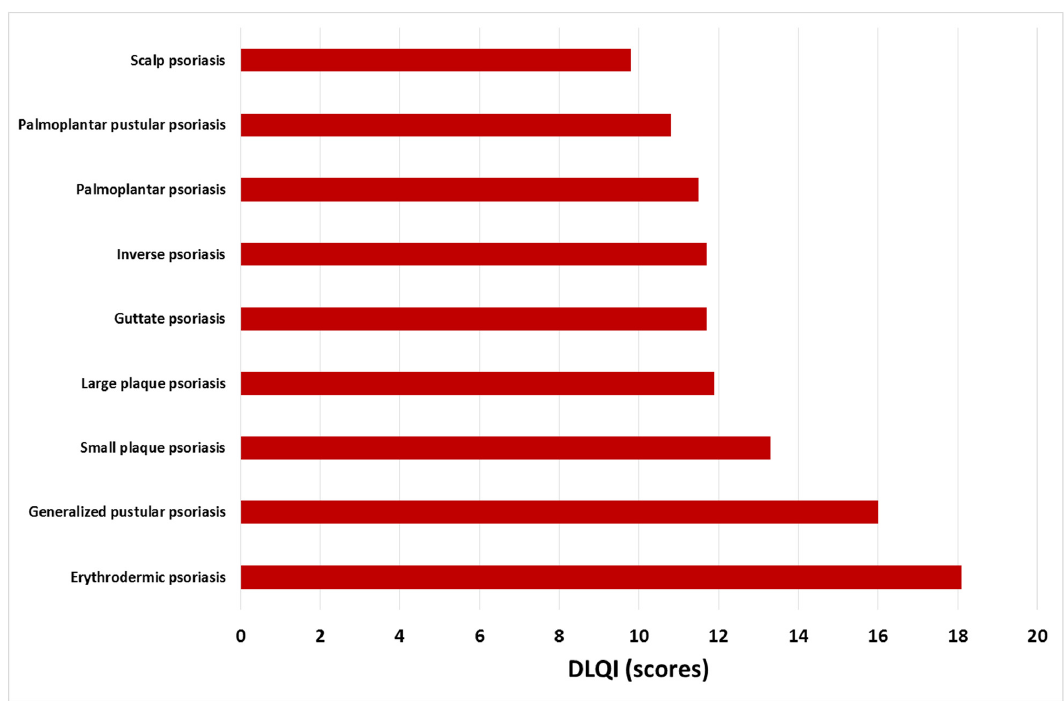
Figure 1. Mean Dermatology Life Quality Index score by clinical subtypes of psoriasis .